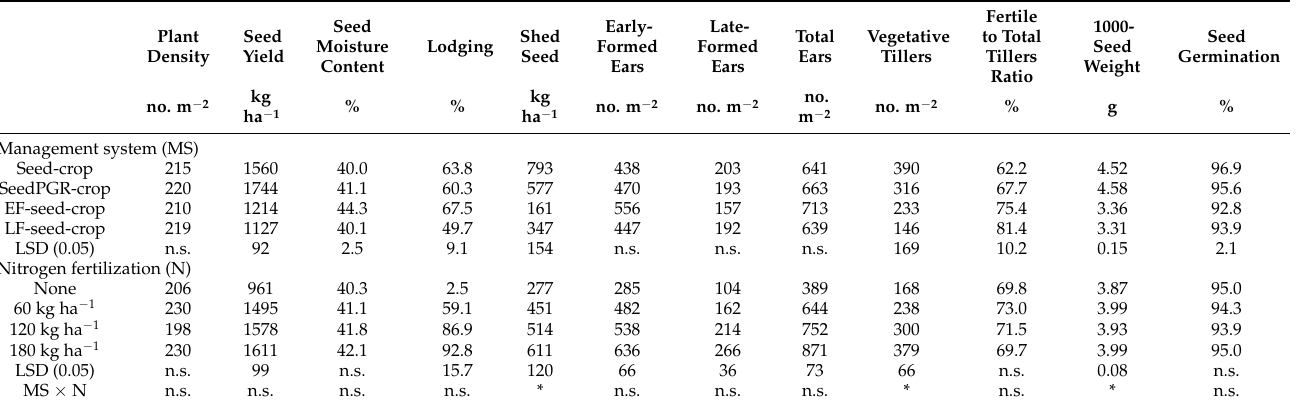
Table 3. Seed yield, yield components, seed shedding and other traits of Italian ryegrass crop as affected by management system and nitrogen fertilization.